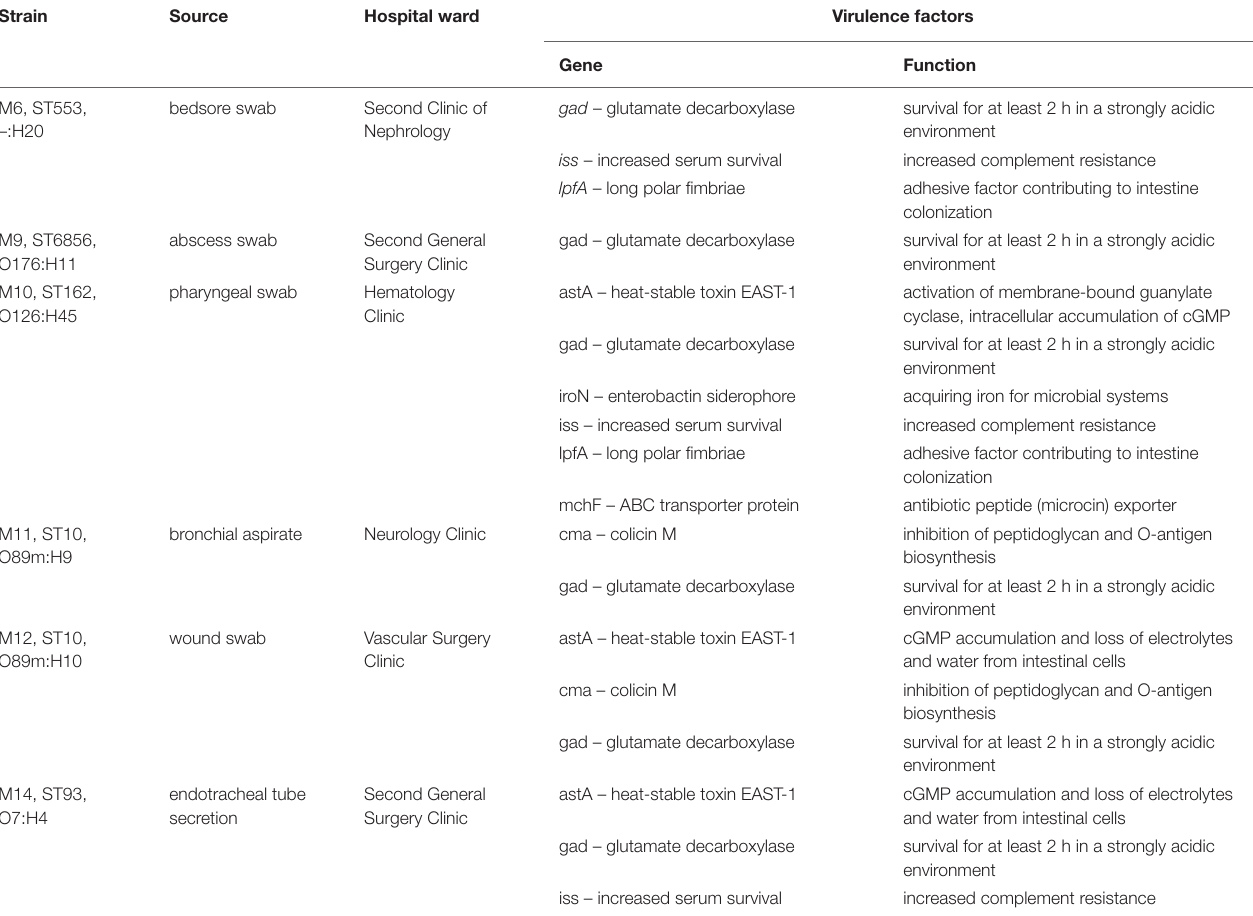
TABLE 5 | Virulence factors in six extraintestinal colistin-resistant E. coli strains.